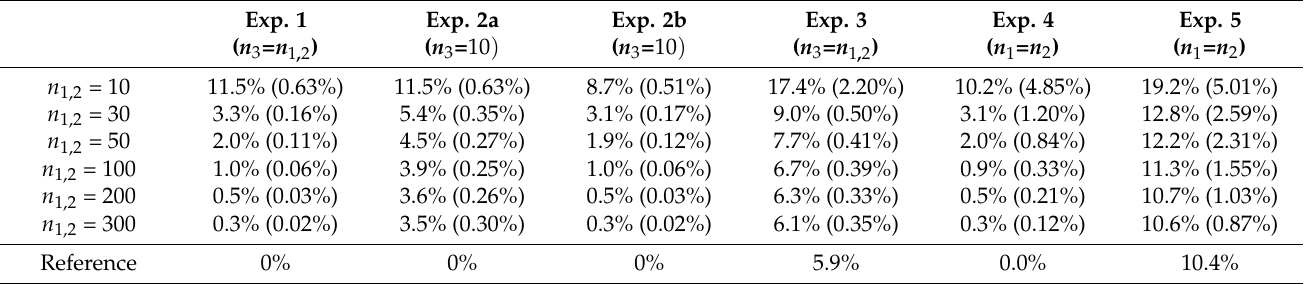
Figure 3. Experiment 1: eigenvalues ( upper row ), mPCA, level 1 component scores ( middle row ), and single-level PCA, component scores ( bottom row ) for sample sizes per group of n l = 10 ( left- hand column ), n l = 100 ( middle column ), and n l = 300 ( right-hand column ) in all groups l = 1,2,3. Group centroids for component scores are shown by the diamonds; x -axis = first component; y -axis = second component. Table 2. Mean (over all MC simulations) of percentage variance of Equation (3) explained by level 1 via mPCA for Experiments 1 to 5. Experiment 2a using standard mPCA, whereas Experiment 2b uses the weighted “population” covariance matrices of Equations (7) and (8). Reference values are given via asymptotic estimates for Experiments 1 to 4 and from experimental data for Experiment 5 ( n 1 = 124; n 2 = 126). (Standard errors are shown in